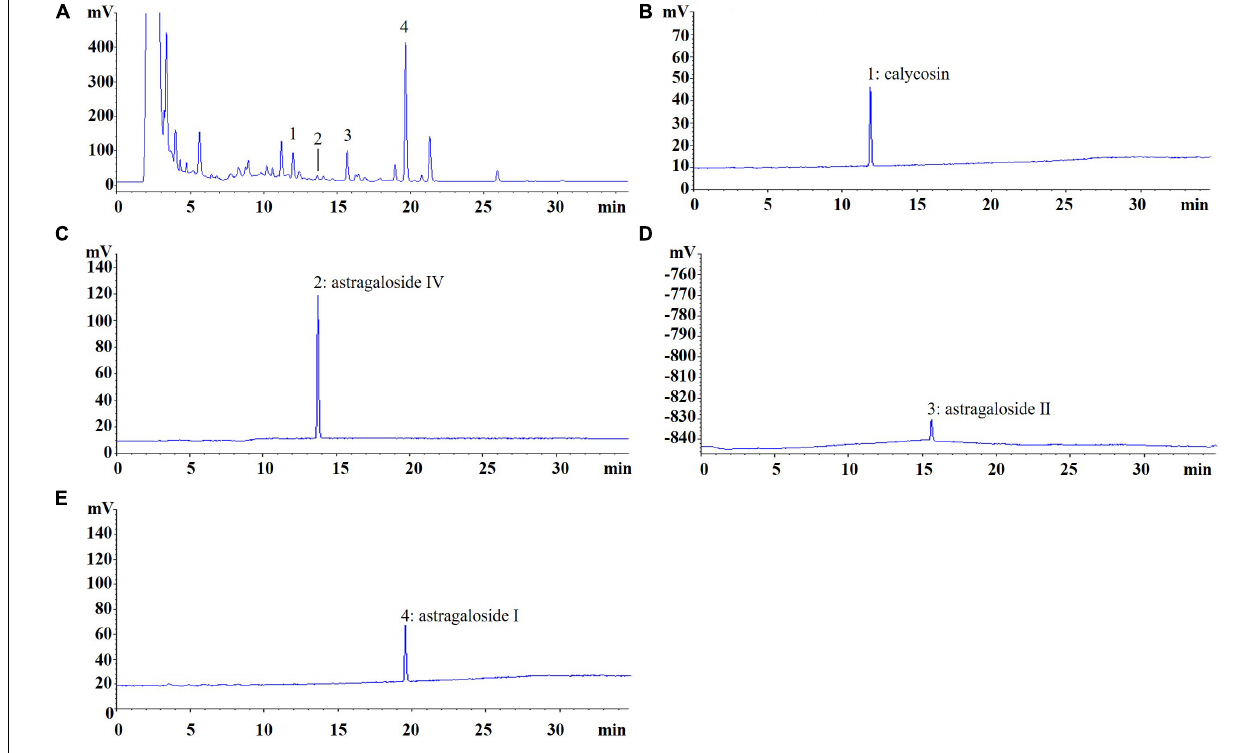
FIGURE 2 | Chromatogram of Astragali Radix (AR). (A) The peak No. refer to standard content, (B) 1: calycosin (0.1129 mg/g); (C) 2: astragaloside IV (0.0037 mg/g); (D) 3: astragaloside II (0.5141 mg/g); (E) 4: astragaloside I (1.4641 mg/g).